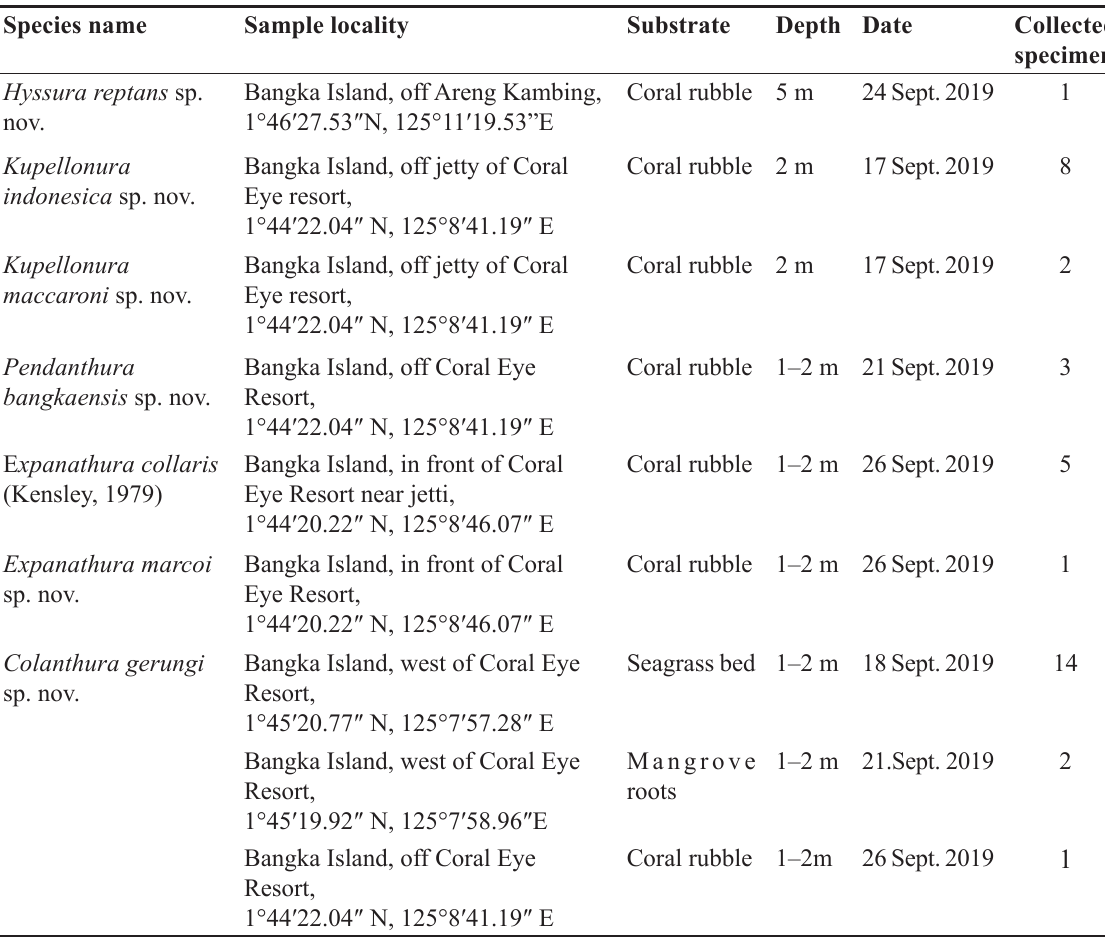
Table 1. Anthuridea collected on the shores of Bangka